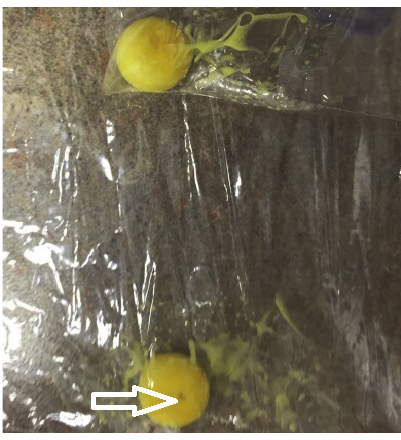
Figure 1: Pearly structures in the stool. The arrow shows a central hole.